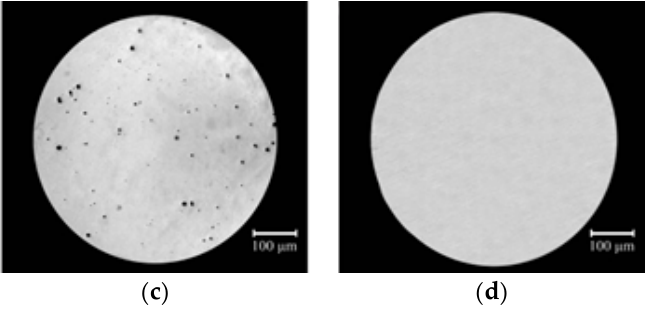
Figure 20. ( a , b ) View of the ECAP–FE ( c , d ) Metallographic observation after FE and ECAP–FE processes [90,91].